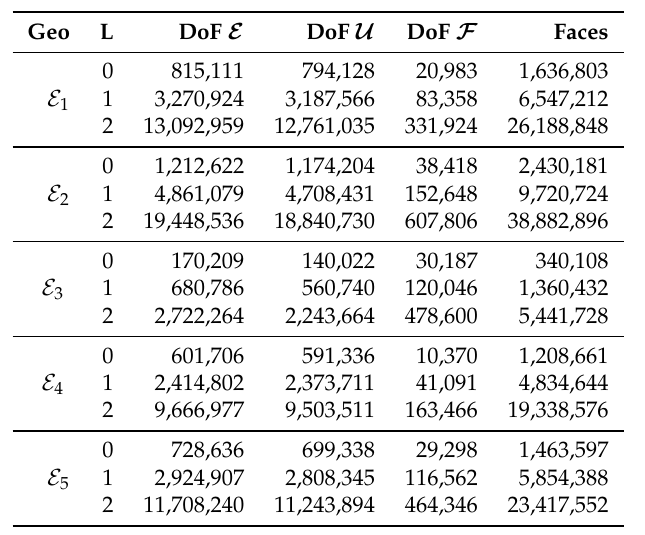
Figure A2 inherits the single (i.e., for each time series) estimated diffusion constant values, their distribution and the averaged diffusion constants evaluated for the 2D case. Figure A3 shows the single and averaged results and the distributions for the computations on the ER surface. Table A3 = 0 for the NS5A/Alone case, for the ER surface depicts the final averaged values for the case r A p based computations and for the classical 2D plane based computations. Table A1. DoF number and total face number of the ER geometries at level L, extracted from our former paper [35].